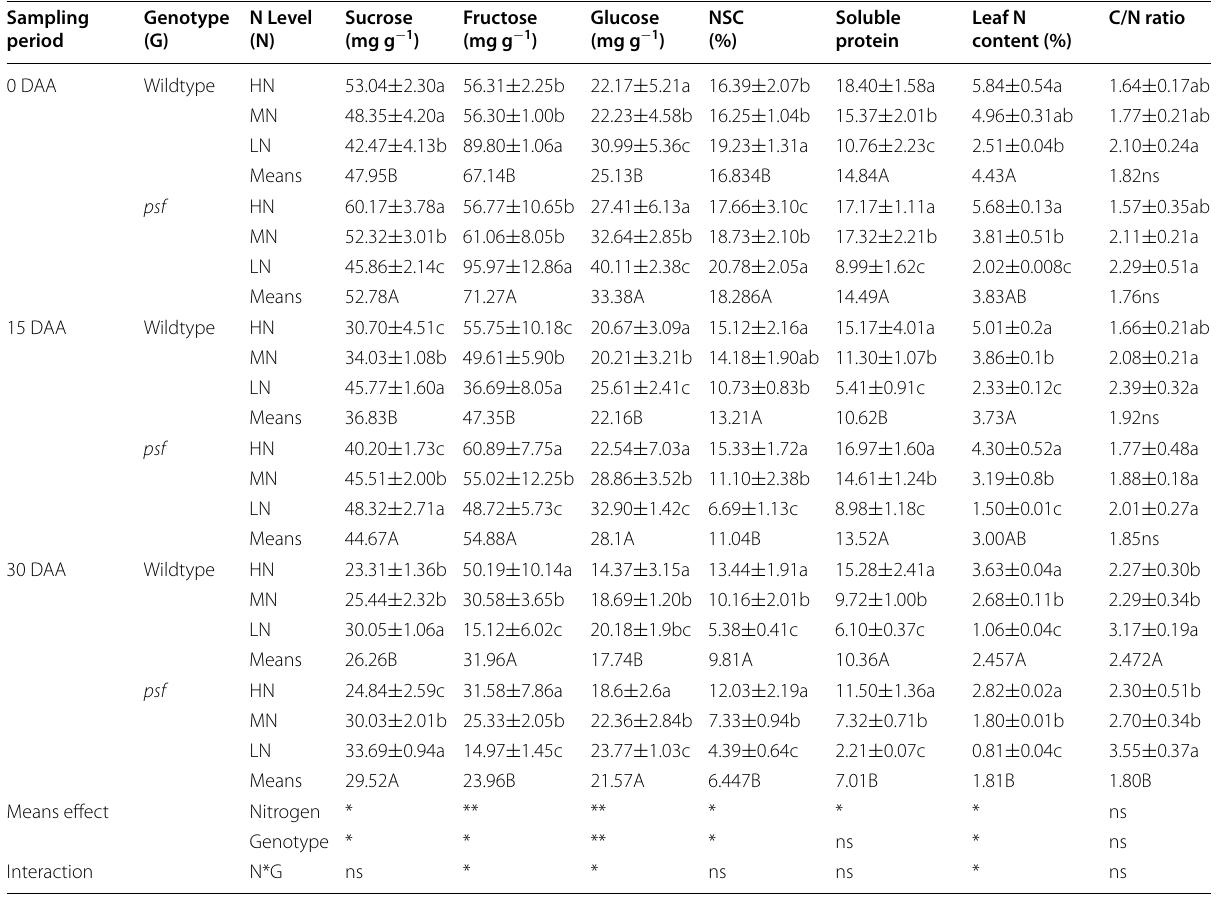
Different letters within the columns indicate a significant difference between nitrogen treatments for a genotype and mean values indicate a significant difference between the genotypes under all the treatments at p 0.05 level least significant difference ≤